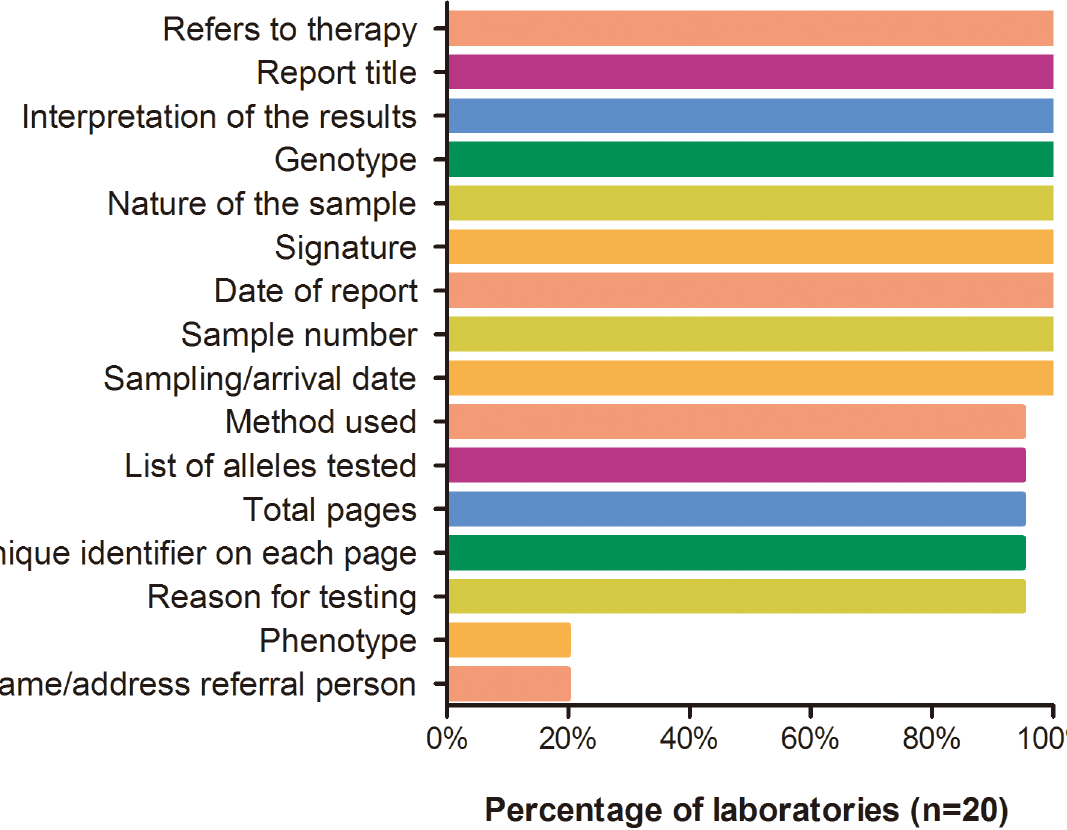
Fig 1. Reporting scores of the CYP2D6 * 10 proficiency testing